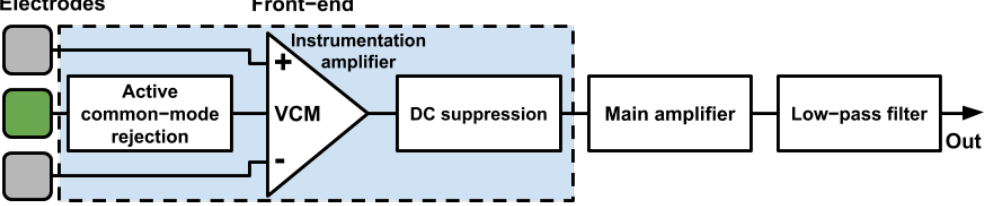
Figure 2. Sensing amplifier block diagram. Electrodes collect the differential voltage together with noise and interference and a third is linked to the active common-mode rejection